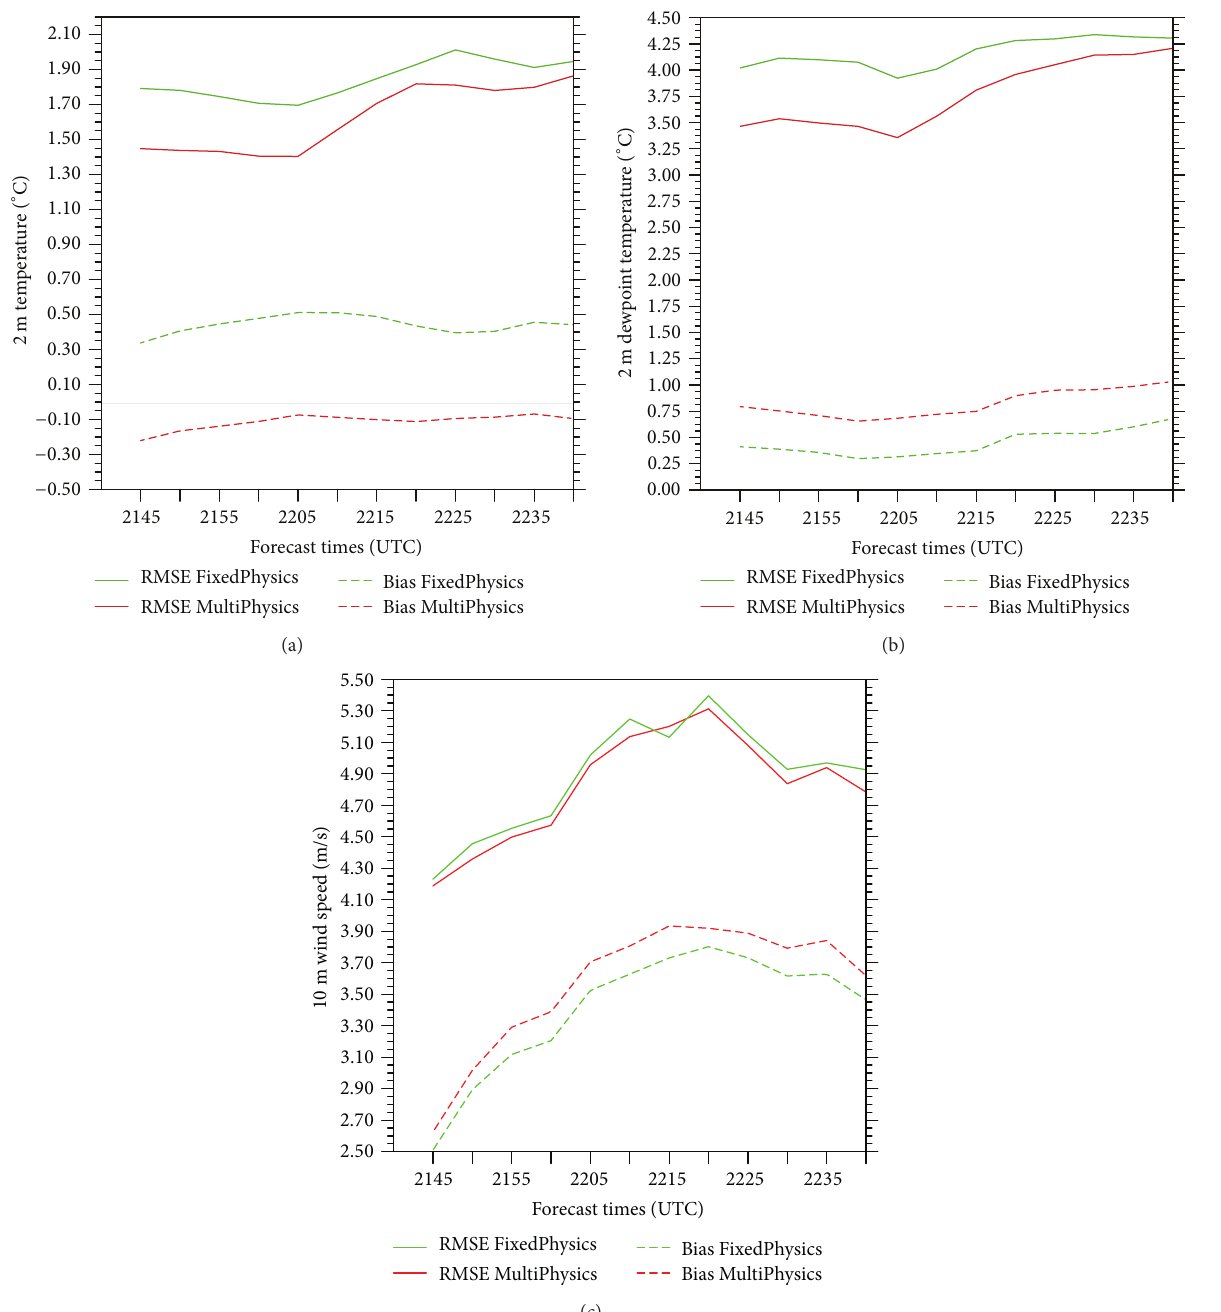
Figure 4: The time series of RMSE and bias (forecast observations) during 1h forecast period for (a) 2m temperatures ( ∘ C), (b) 2 m dewpoint temperature ( ∘ C), and (c) 10m wind speed (ms −1 ) for the FixedPhysics (green lines) and MultiPhysics (red lines) convective-scale ensemble